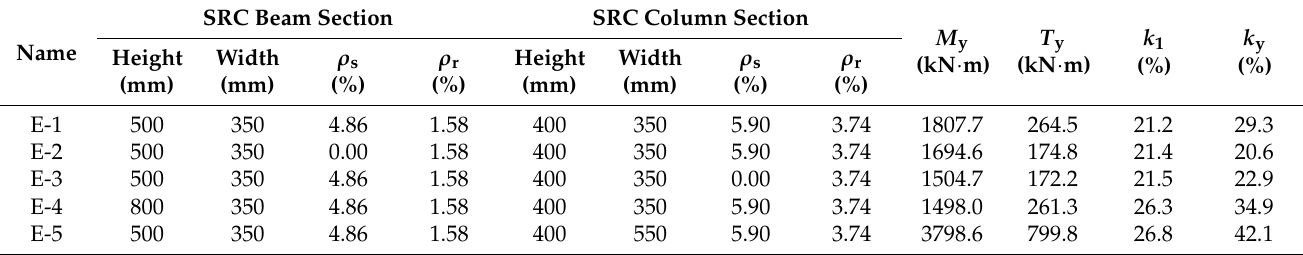
Table 3. Details and results of different cases in the parametric